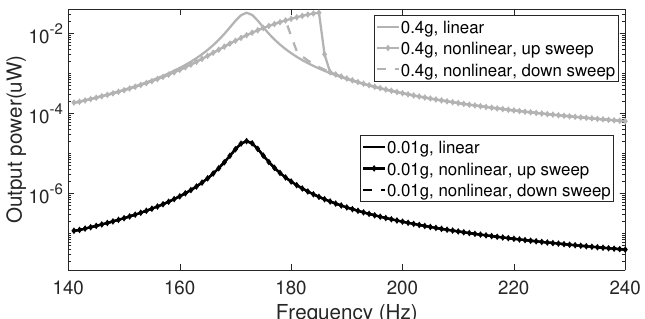
Figure 4. Frequency–response curves for the linear and nonlinear transducer under frequency up and down